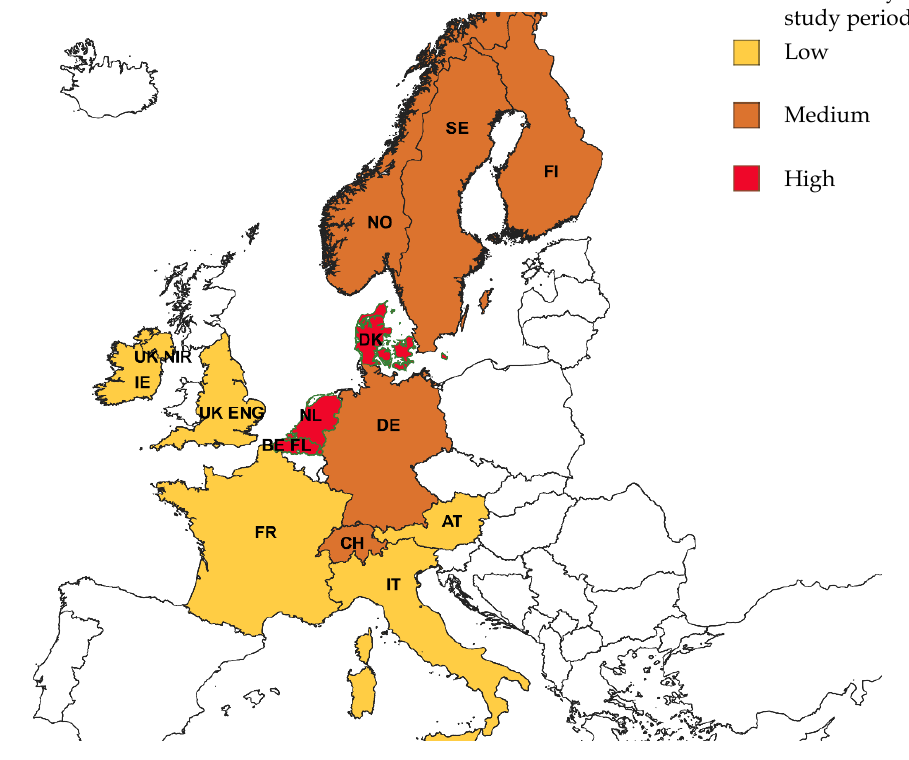
Figure 3. Study regions according to categories of distance cycled per capita per year at the beginning of the study period